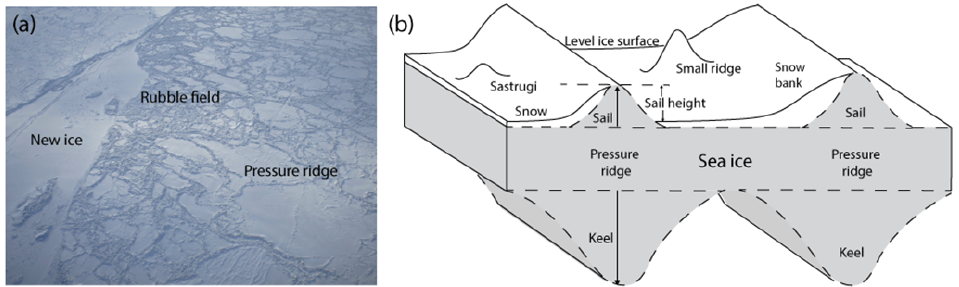
Figure 1. (a) Aerial photograph of the sea ice surface, taken off the coast of Barrow, Alaska. (b) Schematic of a sea ice floe (not to scale) featuring two large pressure ridges, one smaller pressure ridge and a sastruga (snow feature).